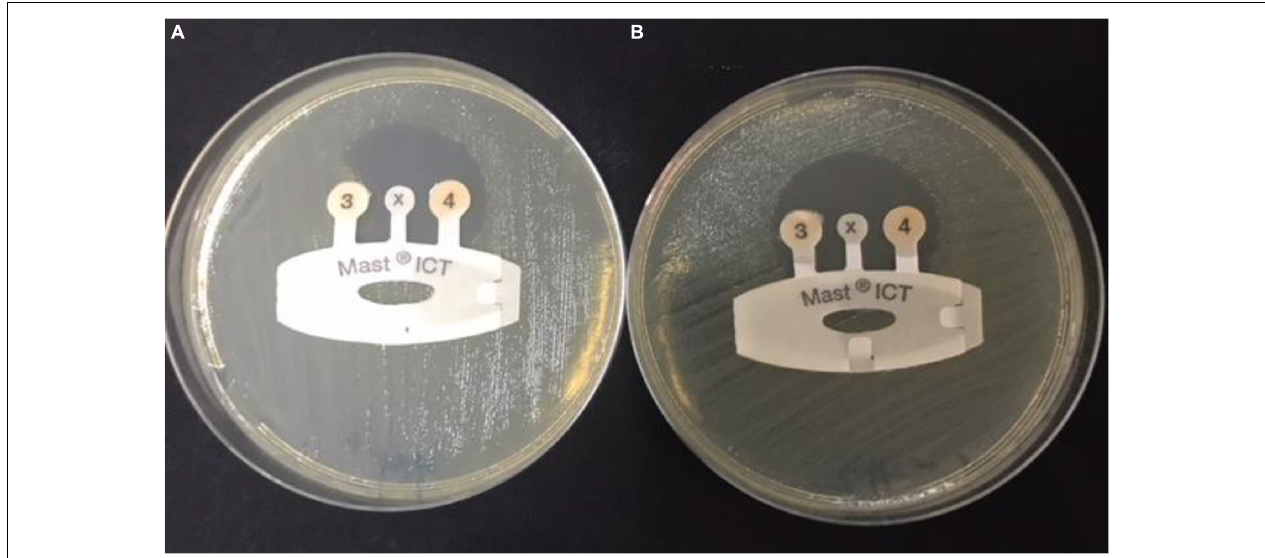
FIGURE 1 | Detection of carbapenemases in carbapenem-resistant Enterobacteriaceae sample by indirect carbapenemase test (ICT). (A) Positive CRE sample: ICT positive, showing carbapenemase production and distortion of the zone around tip 3. (B) Negative sample: ICT negative, showing no carbapenemases production and formation of a regular, circular zone of inhibition around the indicator tip 3. CRE, carbapenem-resistant Enterobacterales.